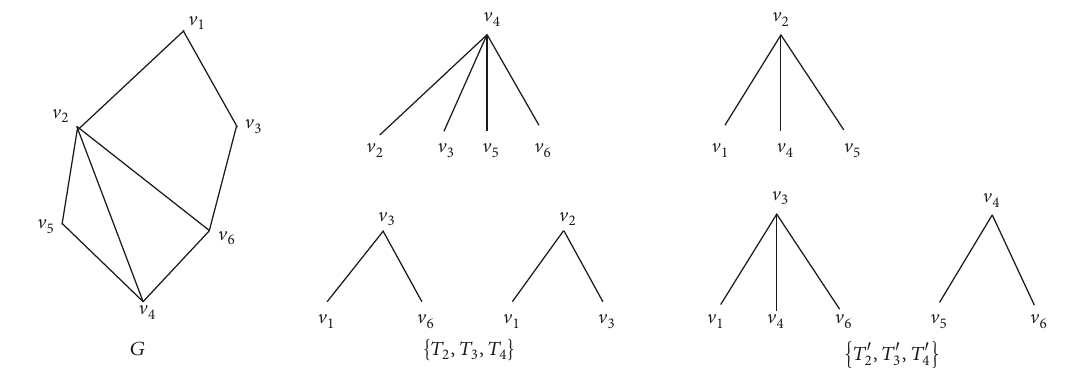
Figure 2: Monitored entity decomposition.